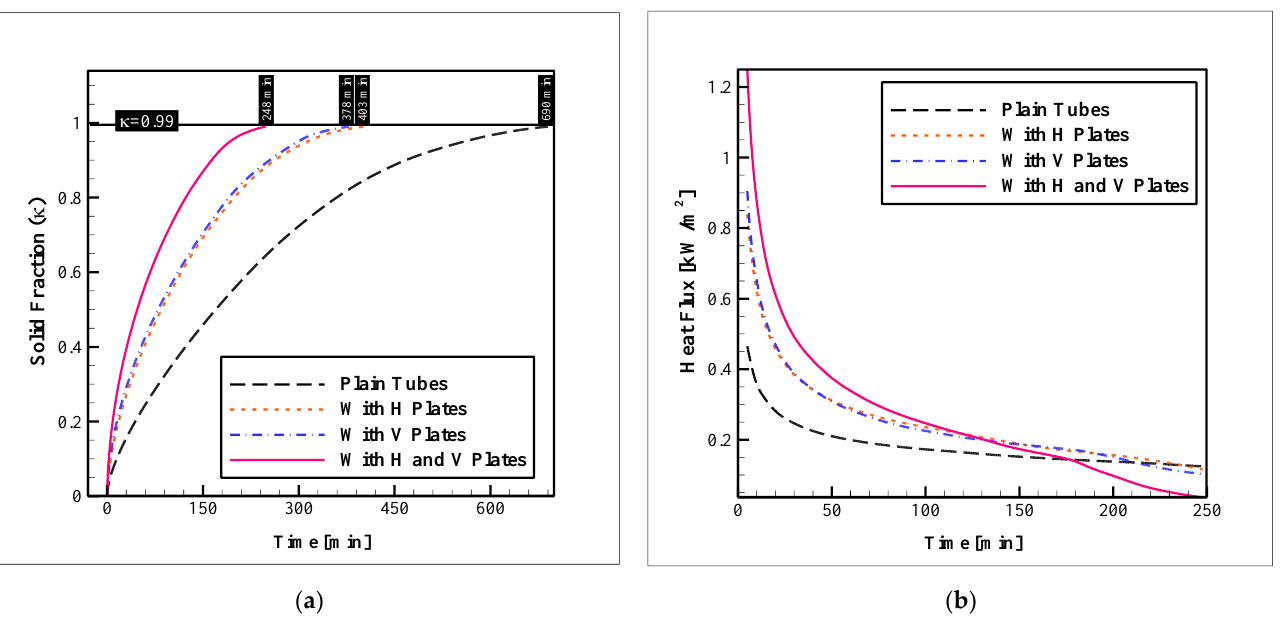
Figure 6. Impacts of the plate-fin network on ( a ) Progression of the average solid fraction; and ( b ) The heat flux passing through the refrigerant tubes.